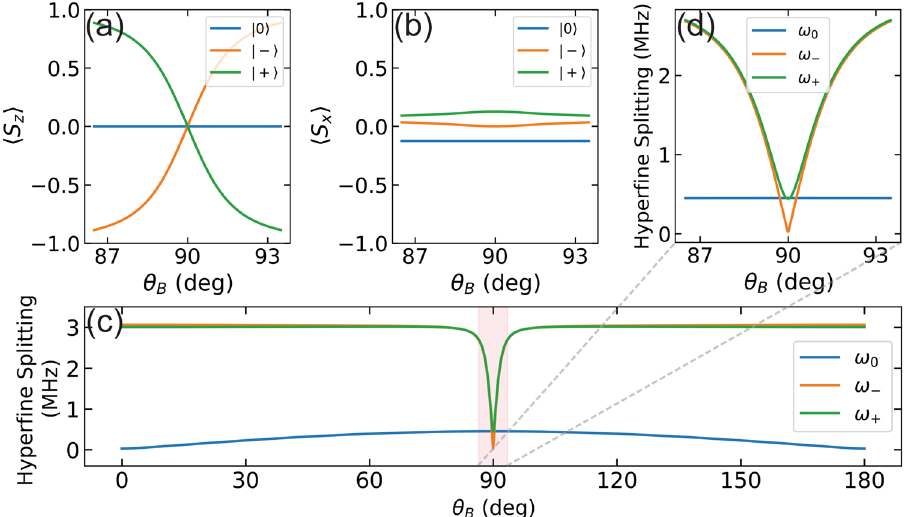
Fig. 2 NV electron spin eigenstate properties under a nearly perpendicular magnetic fi eld. a , b Angle dependence of the electron spin operator expectation values 〈 S 〉 at each state 0 ; ± j i , calculated under ∣ B ∣ = 65 G. 〈 S y 〉 = 0 for all states, thus is not plotted. c , d Angle dependence of the nuclear spin sublevel splittings ω at each electron state. c zooms in on the red shaded area around 90° in ( d ). ω − , the orange curve in ( d ), sharply increases with the off-angle Δ θ B , serving as the key to our angle sensing